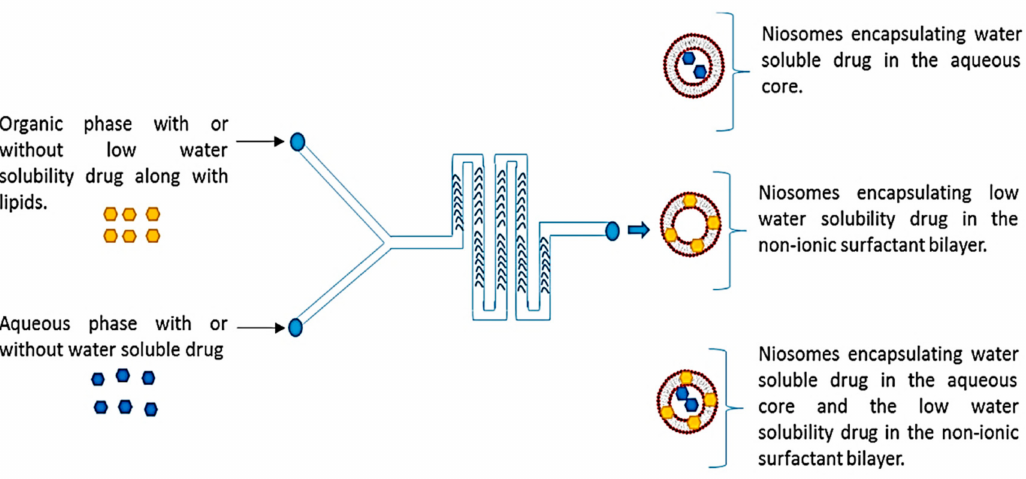
Figure 13. Schematic representing the microfluidic chip structure is having a staggered herringbone micromixer and the whole process of niosome formation. Reprinted from an open-access source [66].